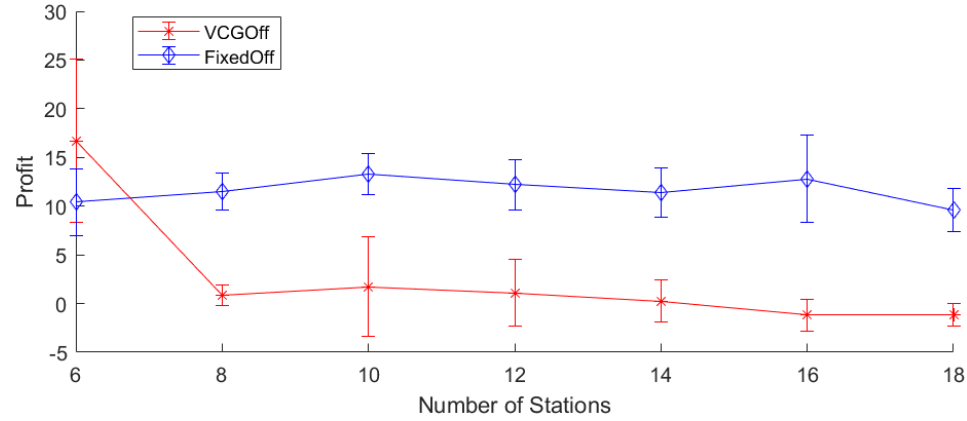
Figure 8. Total profit—variable number of